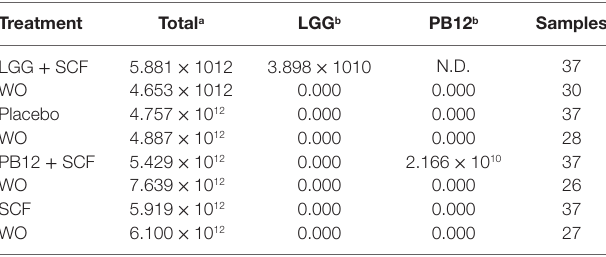
TaBlE 6 | Median quantities of total bacteria, Lactobacillus rhamnosus GG, and L. rhamnosus GG-PB12 in 23 fecal samples. Treatment Total a lGG b PB12 b Samples LGG + SCF